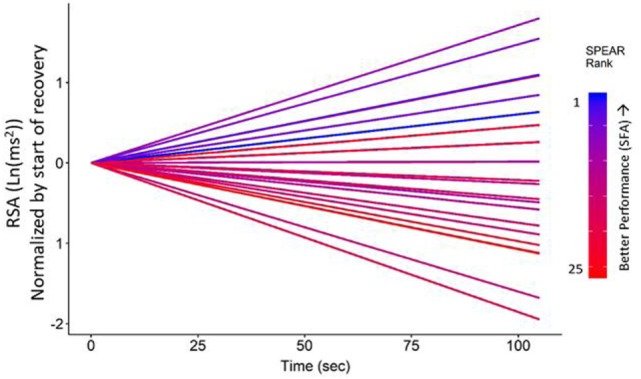
Respiratory sinus arrhythmia (RSA) time trends by Soldier Performance and Effective, Adaptable Response (SPEAR) security force assistance (SFA) ranked score. Recovery of RSA during final recovery baseline prior to the SPEAR task was correlated with greater scores on the SFA block of trials, ρ(20) = 0.58, p < 0.01. SPEAR performance ranked scores are color-coded on a gradient scale ranging from cool, blue colors (highest scores) to reds (low scores). Highest scores were observed in participants who showed increasing RSA across the 2-min recovery period just prior to the SPEAR task.